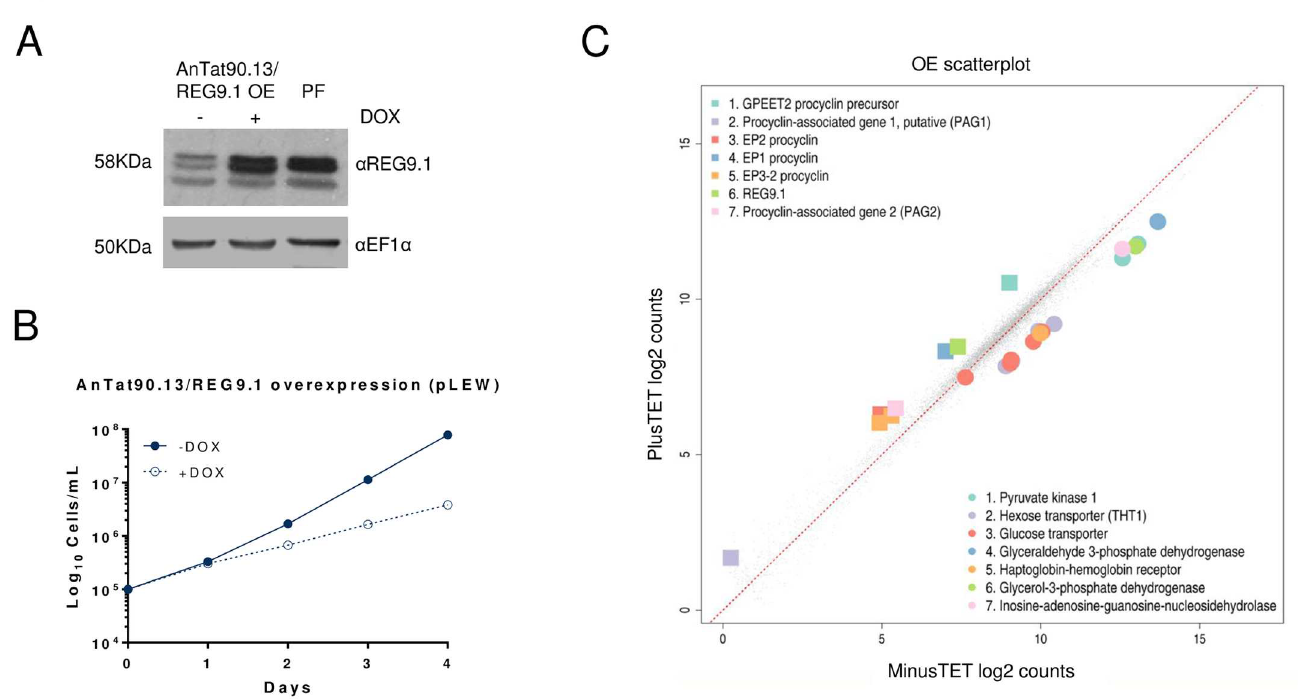
Fig 7. Pleomorphic trypanosomes expressing REG9 . 1 ectopically using pLEW expressprocyclic form mRNAs. A. Ectopic overexpression of REG9 . 1 in pleomorphic bloodstreamforms. The panel shows the expressedREG9.1 detected with an antibodyto the protein in bloodstream forms (inducedor uninducedfor overexpression using pLEW), with procyclic form (PF) samplesincludedto demonstrate that similar levels of expressionto procyclic forms were generateduponinduction. B . In vitro growth of parasites inducedto express REG9 . 1 from the pLEW expression vector. C. Transcripts up and down regulatedupon REG9 . 1 ectopic expressionusing pLEW in pleomorphic trypanosomes. The data represents an analysisof two biological replicates whethercells were inducedor not to ectopicallyexpress REG9 . 1 .